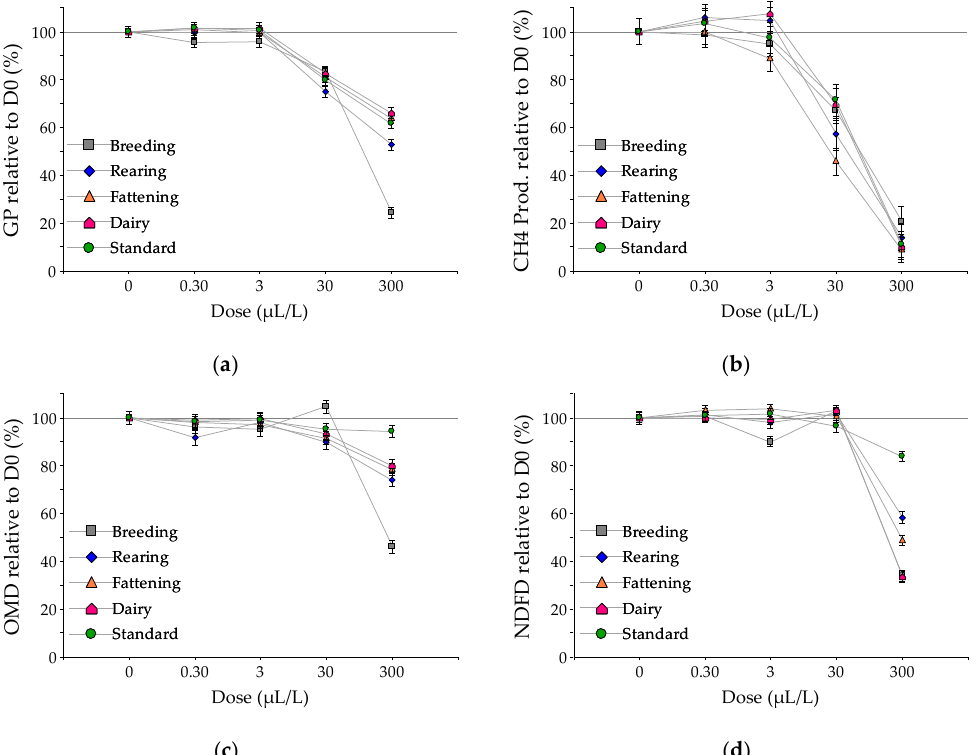
Figure 3. Relative responses compared to control (dose 0 = 100%) for ( a ) total gas production; ( b ) methane production; ( c ) organic matter digestibility (OMD) and ( d ) neutral detergent fiber digestibility (NDFD), to increasing doses of Lippia turbinata essential oil in the in vitro fermentation of substrates representing diets of different livestock production systems: breeding (gray), rearing (blue), fattening (orange), and dairy (pink), and a laboratory standard substrate (green).